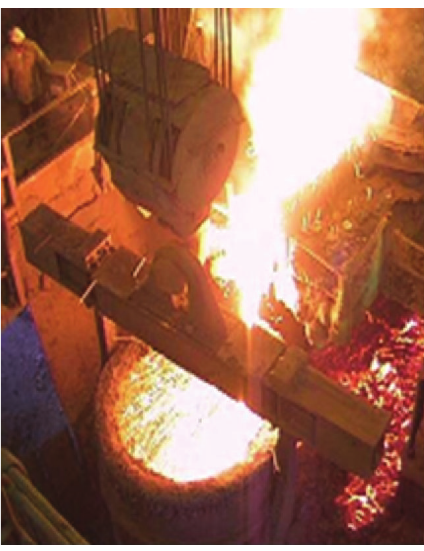
Figure 1: Electric arc